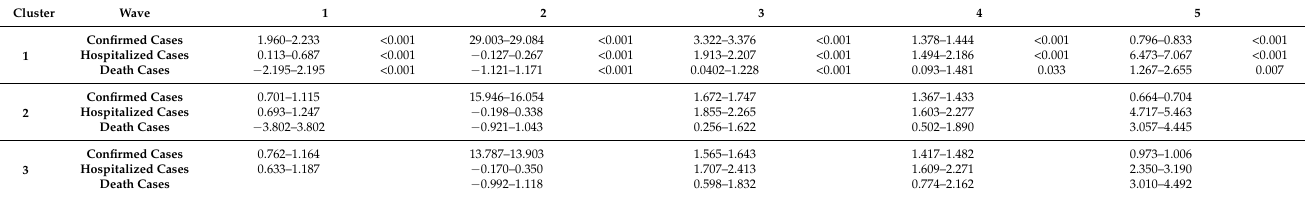
Table 2. The 95% Confidence Intervals (CI) (left) for the Relative Risk of each cluster (1–3) and cluster 4 (reference) for each wave for confirmed, hospitalized, and death cases and p -values